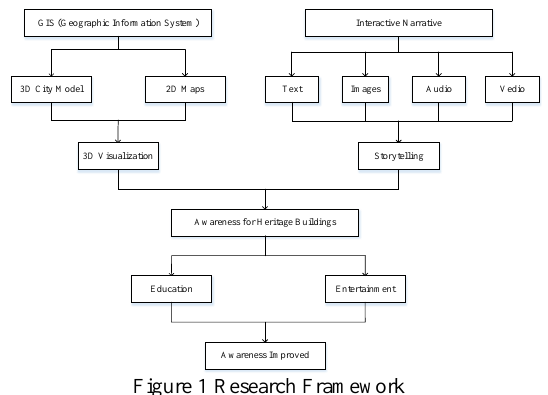
Figure 1 Research